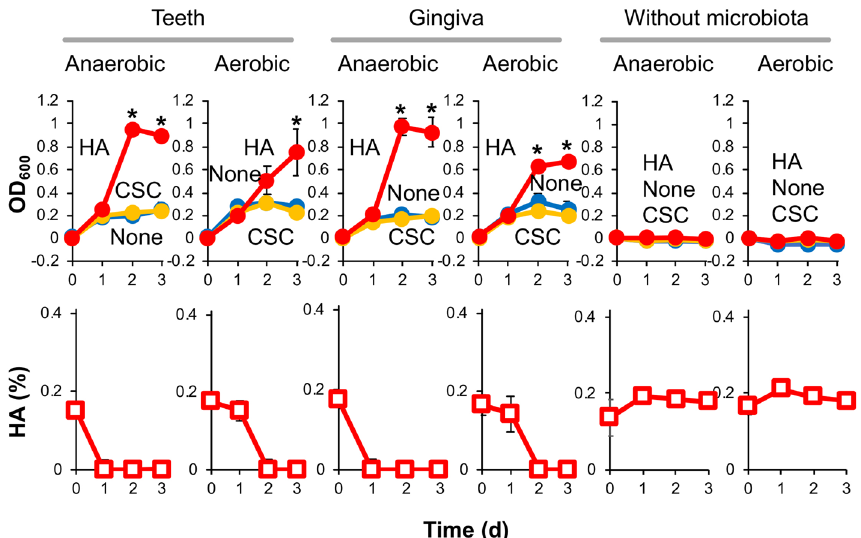
Figure 4. HA and CSC assimilation by human oral microbiota. Growth of microbial community from the teeth (left) or gingiva (center) of donor #1 in nutrient-poor medium (1/20 × GAM; blue) or the same liquid medium but containing HA (red) or CSC (yellow) as a carbon source (top). * p < 0.05, significant growth promotion compared to growth in nutrient-poor medium (1/20 × GAM; t test). HA concentrations during growth in HA-containing medium were determined (bottom). These experiments were also carried out without human oral microbiota as a negative control (right). The oral microbiota from teeth or gingiva of a healthy donor assimilated HA under both anaerobic and aerobic